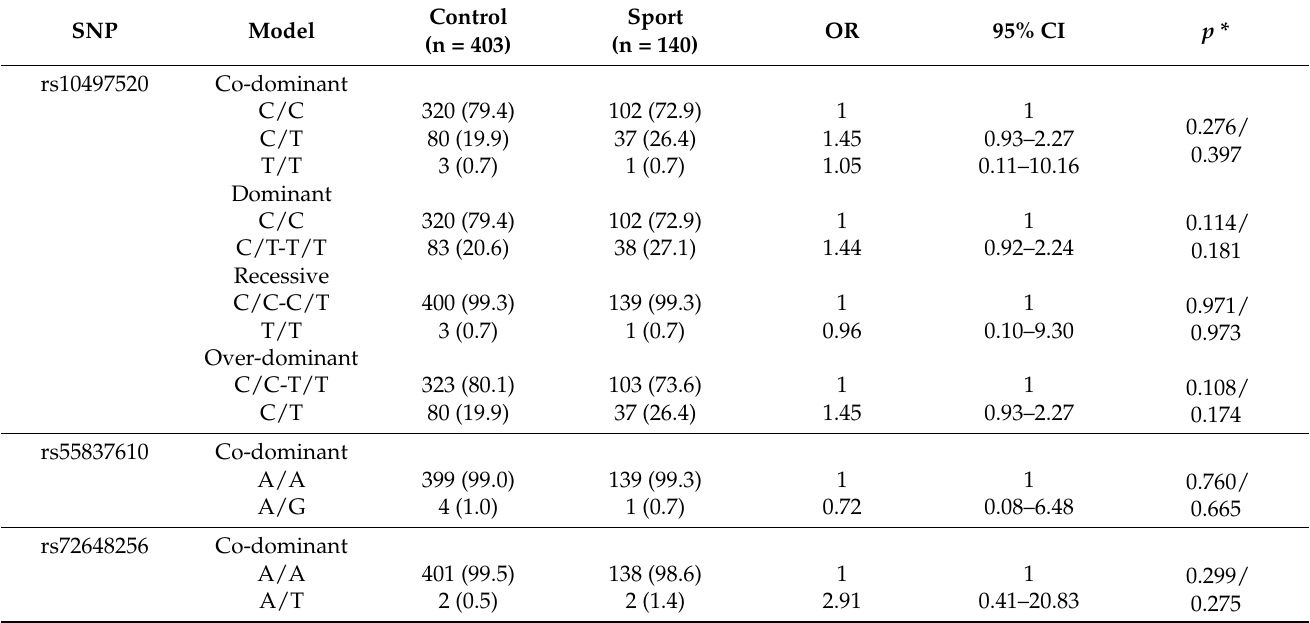
Table 4. Single SNP association analysis for cases (mixed-sports) and